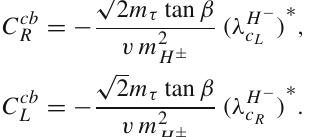
= 350 GeV (right panel) 2